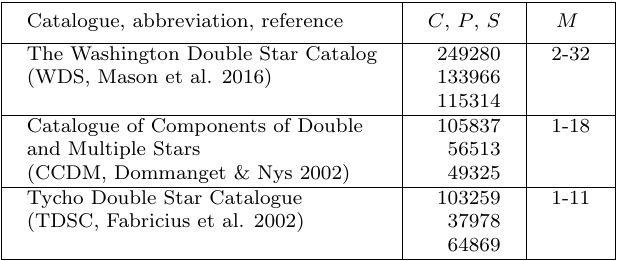
Table 1. Principal catalogues of visual double and multiple